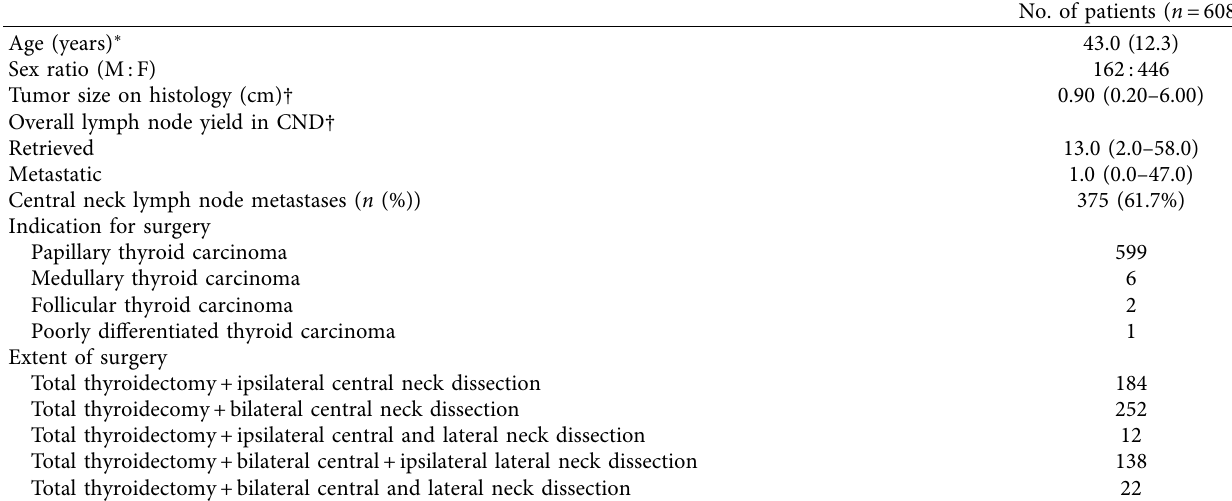
Table 1: Demographic and clinical details of patients who underwent total thyroidectomy plus central neck